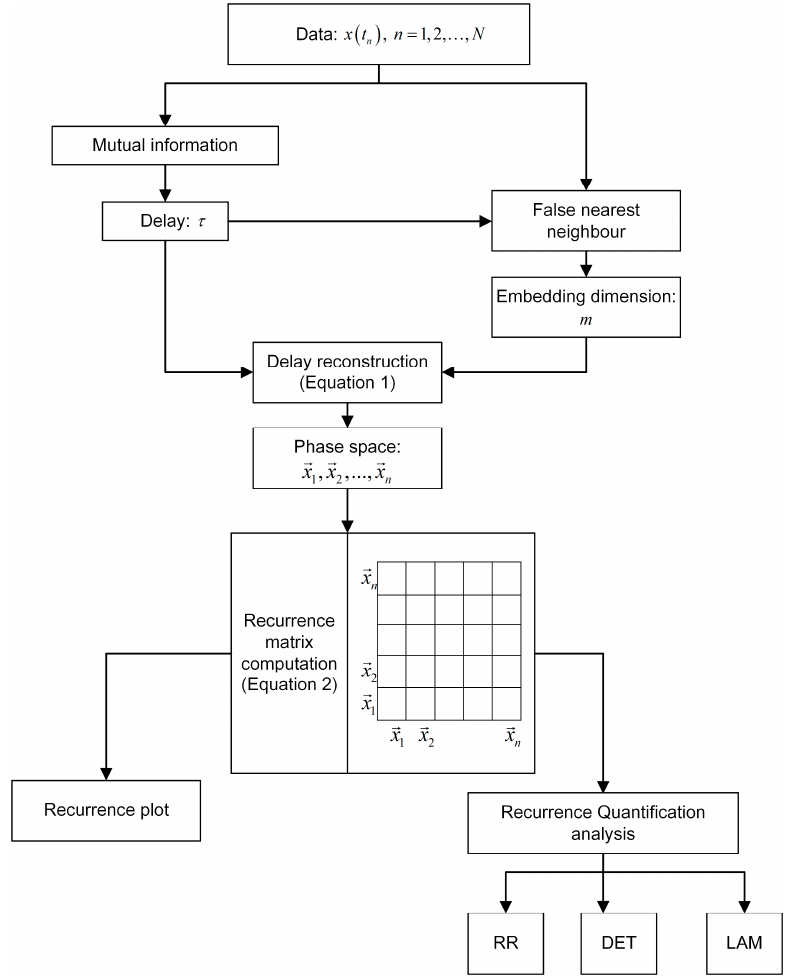
Figure 3. The framework of recurrence analysis.